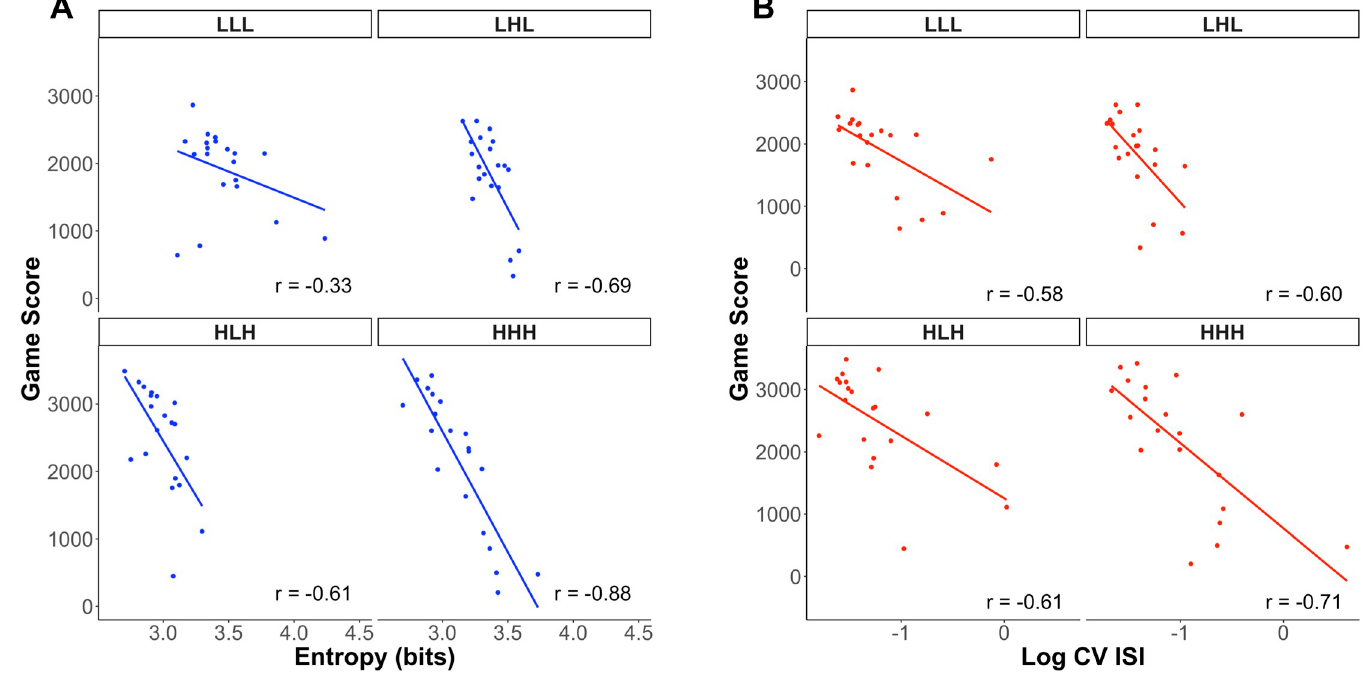
Fig 9. Correlation between human average game score and human average motor variability in terms of the entropy and shot timing variability in the Final phase. (A) Correlation between human average game score and average entropy. (B) Correlation between human average game score and average shot timing variability in terms of the logarithmic CV of the